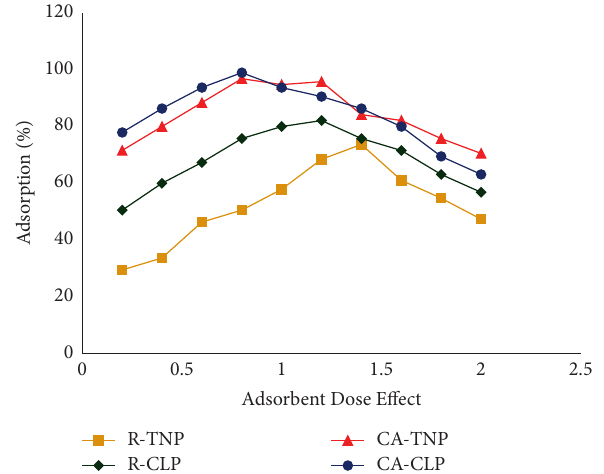
Figure 7: Effect of adsorbent dose on adsorption. Experimental conditions: adsorbent dose range 0.2 to 2.0g, conc. � 25ppm, vol- ume � 25mL, temperature 30 ° C, initial pH � 5, final pH: R-TNP � 5, R-CLP � 4.5, CA-TNP � 4.0, and CA-CLP � 4.0, contact time � 30min, and agitation speed �